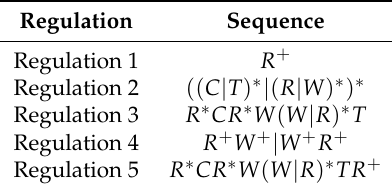
Table 1. Regulation sequence and character